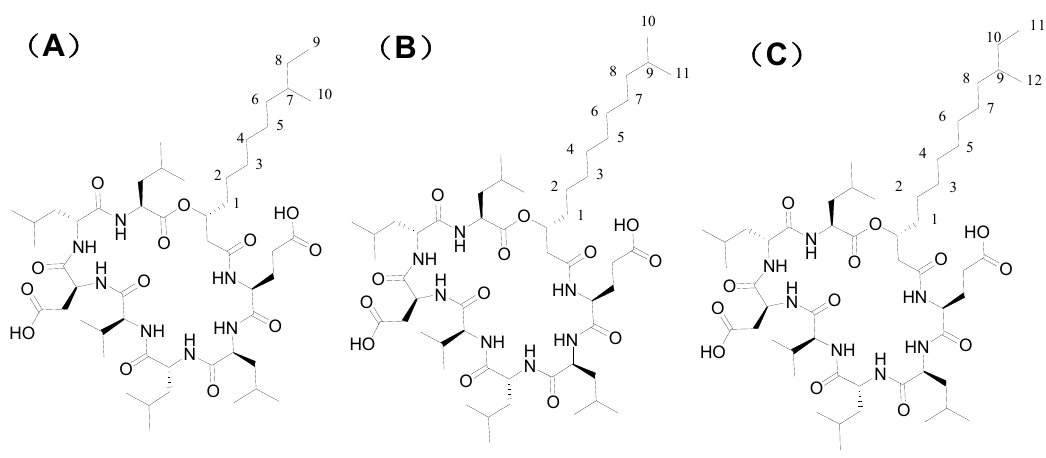
5, ( B ) NT-6 and ( C ) NT-7.